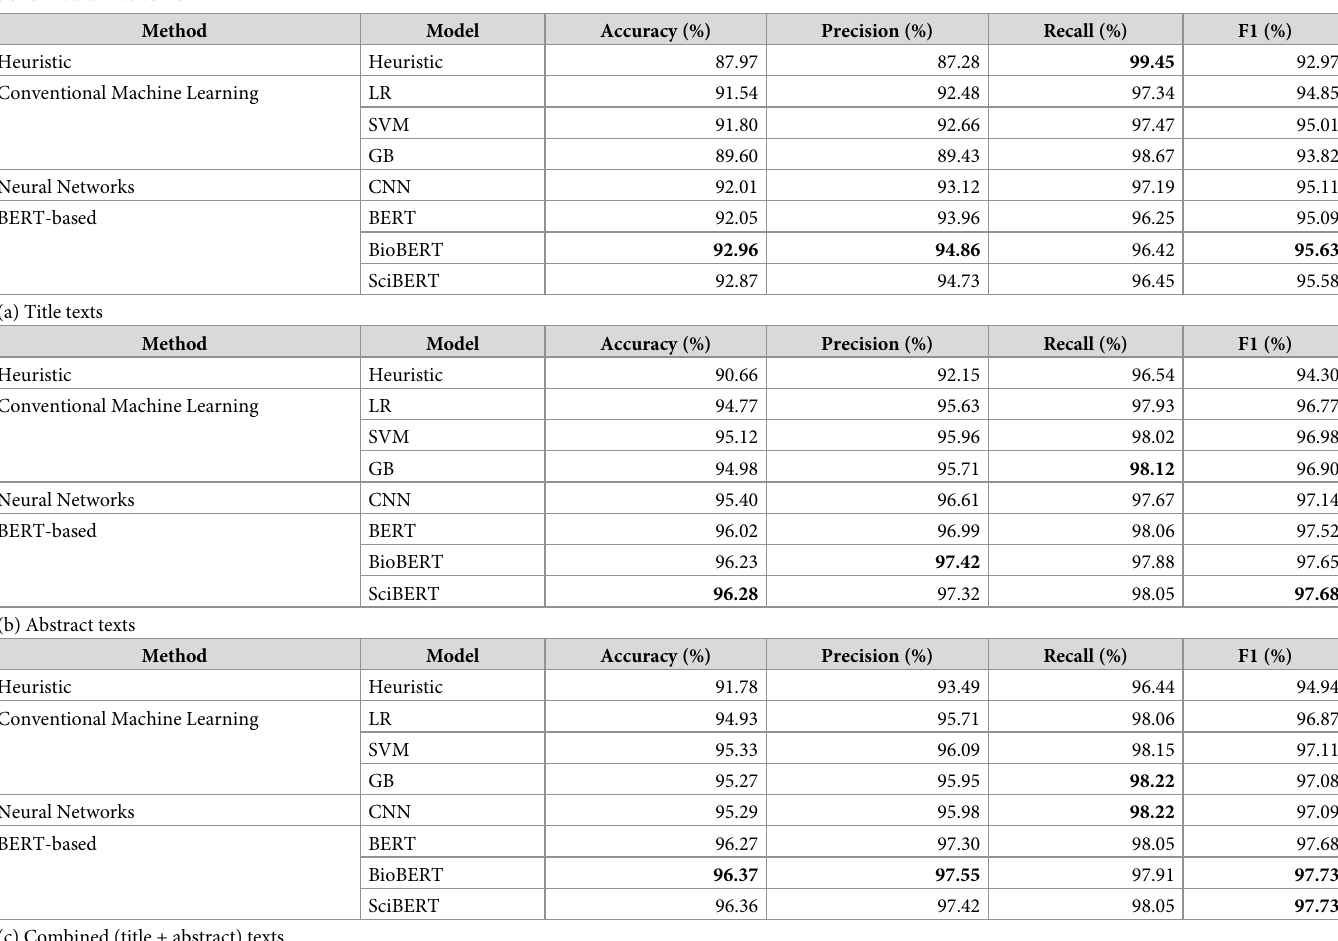
Table 4. Summary of evaluation results for predicting non-RCTs with a heuristic model, three conventional machine learning models (LR, SVM, and GB), a neural networks model (CNN), and three BERT-based models (BERT, BioBERT, and SciBERT) for using (a) title, (b) abstract, and (c) combined title and abstract as input data. Bold indicates the best performance results among all the models. LR: Logistic Regression, SVM: Support Vector Machines, GB: Gradient Boosting, CNN: Convolu- tional Neural